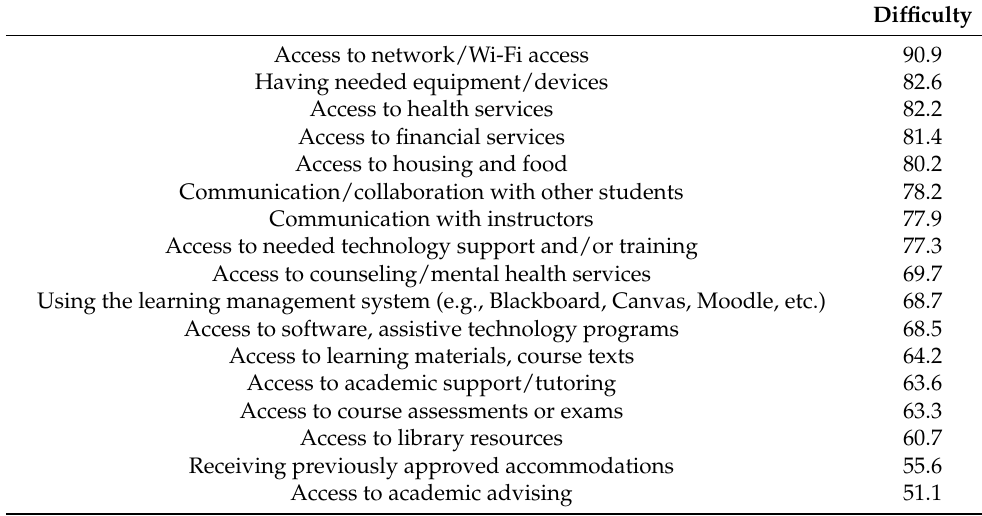
Table 2. Disability resource professionals’ perceived barriers of students with disabilities during COVID-19 (two months into pandemic, n = 535), by